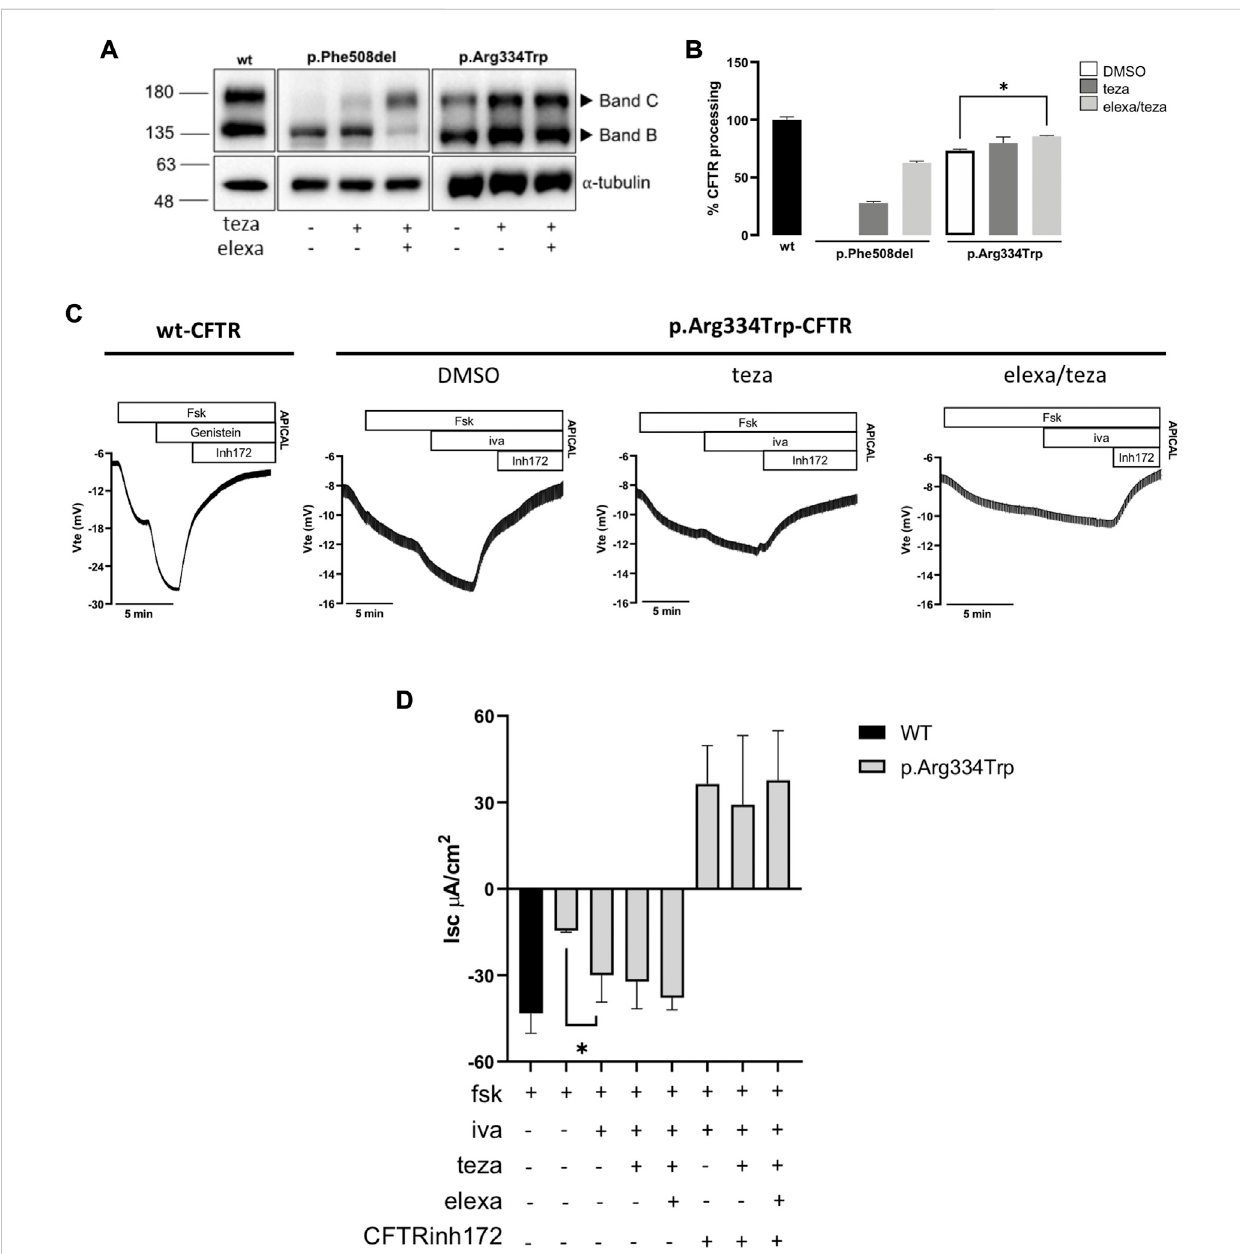
FIGURE 3 CFTR modulators effect on CFTR expression and function in CFBE cells expressing p.Arg334Trp-CFTR. (A) Western blot (WB) analysis of p.Arg334Trp-CFTR stably expressed in CFBE cells after 24 h treatment with 5 μ M teza alone or combined with 3 μ M elexa. Cells expressing F508del- CFTR were analysed as a control. As a loading control α -tubulin was used. (B) CFTR processing analysed as the percentage of band C to total CFTR and normalized to the ef fi ciency of processing of wt-CFTR (shown as mean ± SEM of three replicates). Signi fi cance was considered for p -value ≤ 0.05 and * symbol represents signi fi cance vs. DMSO (ANOVA). (C) Original Ussing Chamber (short-circuit) recordings of CFTR-mediated chloride secretion measured as transepithelial voltage (V te ). Fsk was added apically followed by iva to cells pre-treated with DMSO or 5 μ M teza alone or combinedwith3 μ Melexa.DMSOwasusedasvehiclecontrol. (D) Summaryofequivalentshort-circuitcurrents(I sc-eq )inducedbyfsk,iva+fsk,teza/iva+ fsk and elexa/teza/iva + fsk. Values are represented as mean ± SEM ( n = 4). Signi fi cance was considered for p -value ≤ 0.05 and * symbol represents signi fi cance vs. stimulation with fsk alone after DMSO